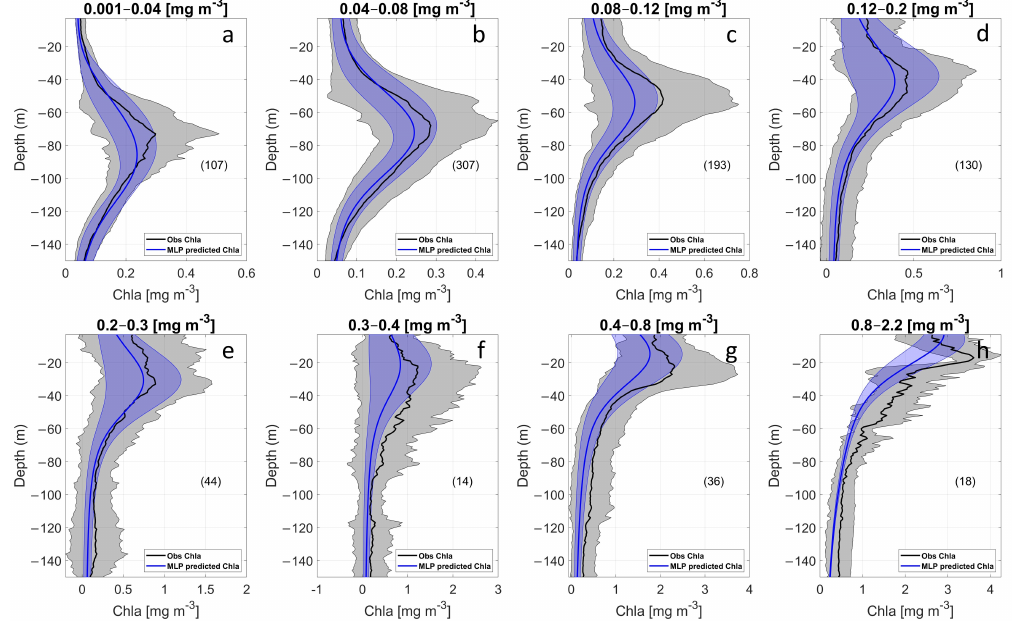
Figure 5. ( a – h ) Comparison of the mean profiles of the observed (black line) and MLP (blue line) chlorophyll values modelled from surface satellite data and grouped according to di ff erent surface trophic classes (in bold at the top of each panel). For each panel the black line is computed averaging all the observed profiles falling within specific surface chlorophyll class. The blue line is obtained from the average of all MLP corresponding profiles. The shaded areas represent their respective standard deviations. The number in brackets refers to frequency of training observed profiles for each surface trophic class. These results are referred to the test